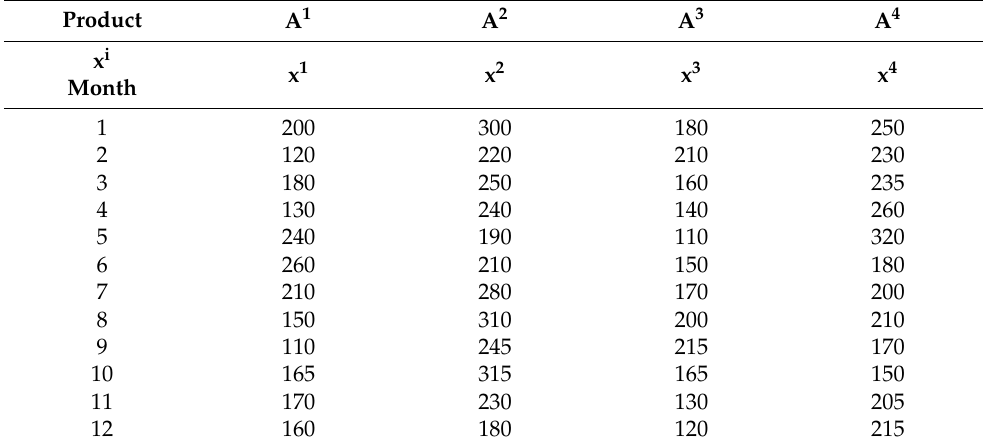
Table 3. Quantity of supplied stocks of four products for the previous 12 months (in kg).